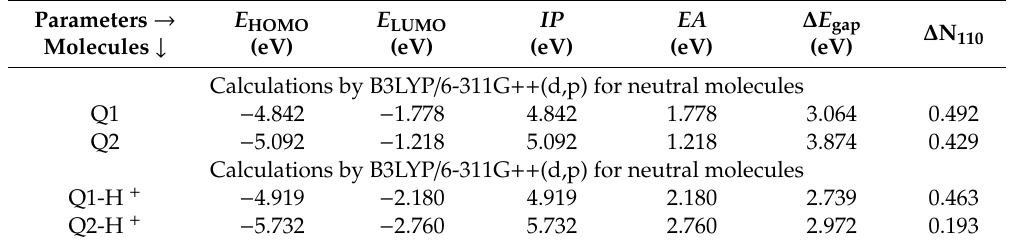
Table 5. Calculated quantum chemical indices of the studied compounds in their neutral and protonated